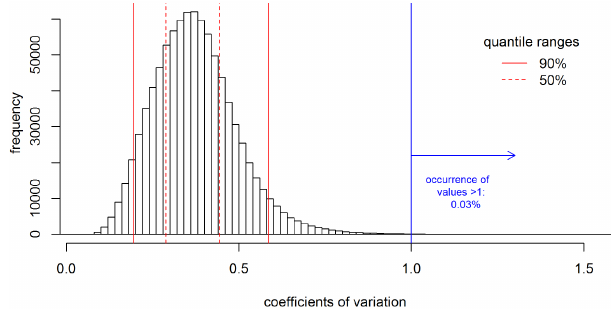
Figure 6. Coefficient of variation for the LST time series data. The median coefficient of variation is 0.34, the mean value 0.35. In all, 90% of the calculated values are within the range of 0.19 and 0.55 (red lines), 50% are within the range of 0.27 and 0.42 (red dashes) and 0.03% of the values are larger than 1 (blue